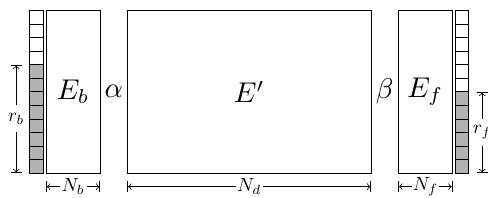
Figure 1: Differential key-recovery attack on block cipher E